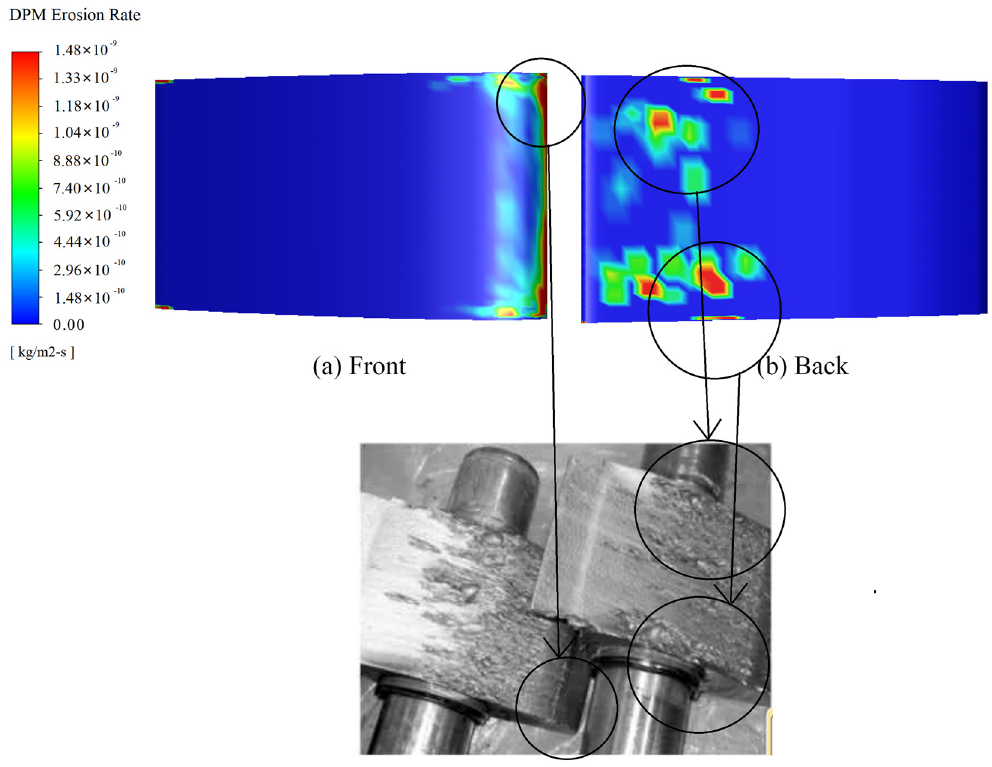
Figure 12. Simulation results compared with the actual measurement of the power station. ( a ) Front, ( b ) Back.